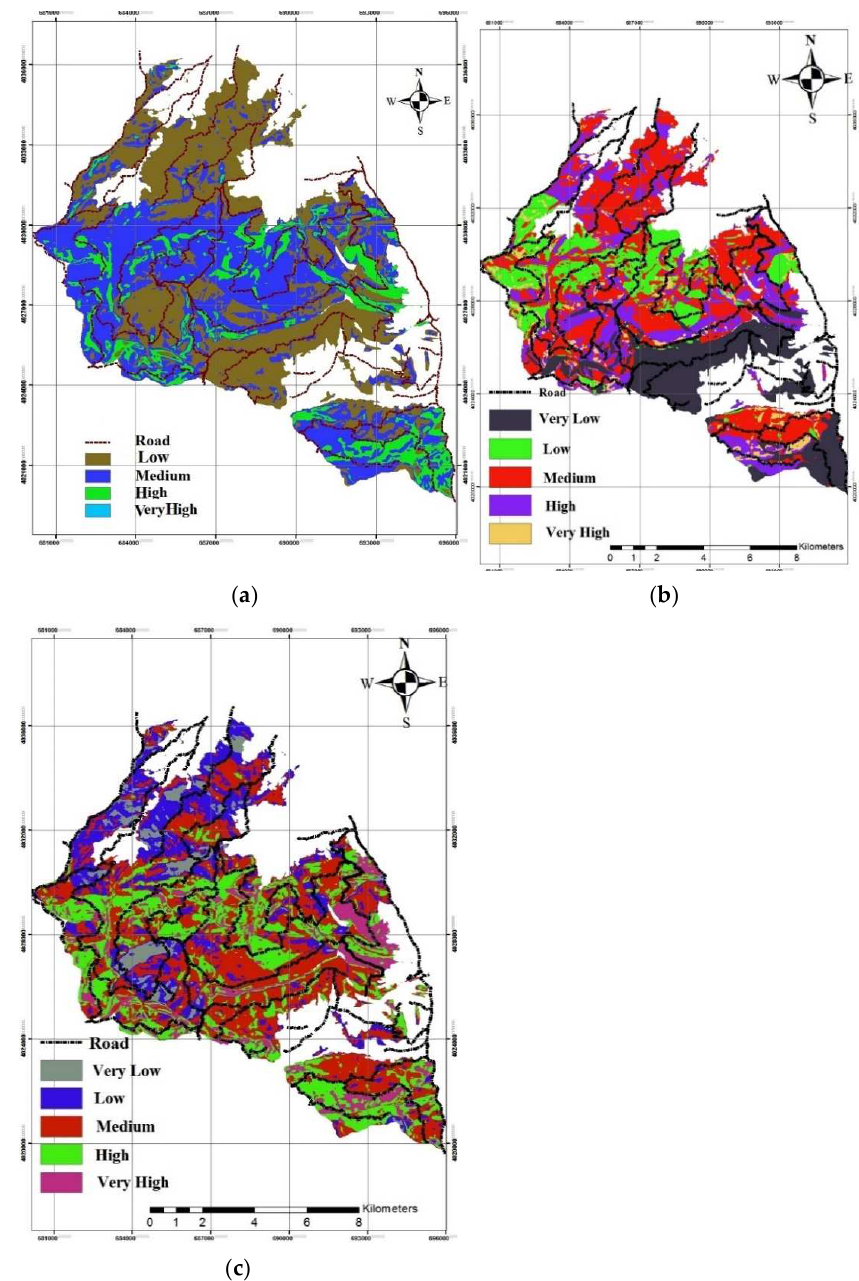
Figure 4. Landslide susceptibility maps created using ANFIS and frequency ratio models: ( a ) Frequency ratio; ( b ) triangular MF; ( c ) Gaussian MF.